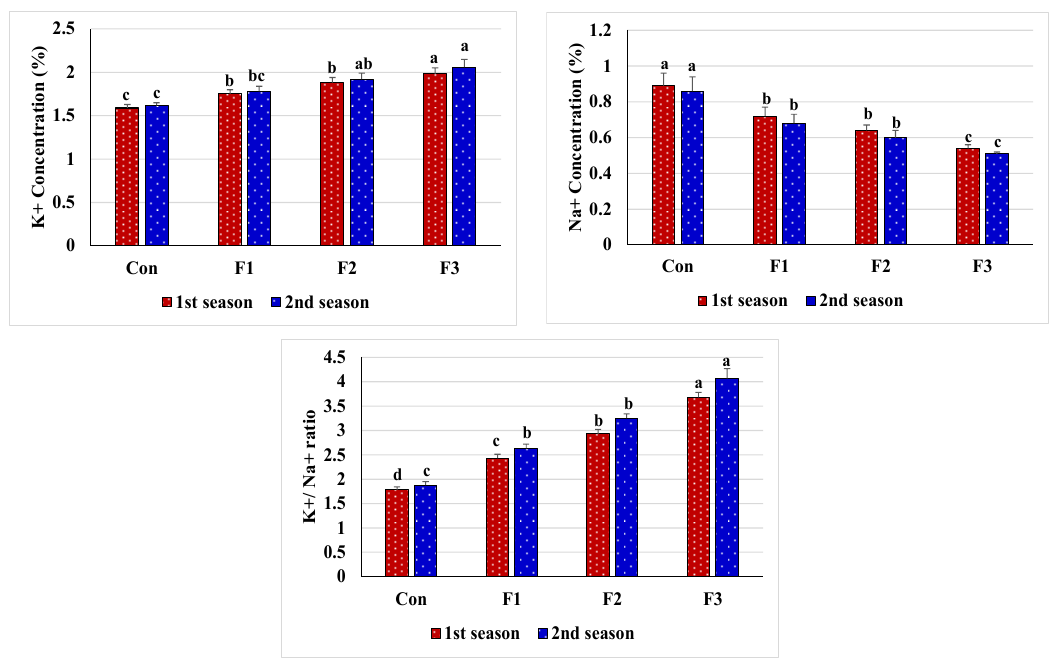
Figure 3. Nutrient content response of salt-stressed common bean plants (soil EC = 7.55–7.61 dS m − 1 ) to foliar nourishment with selenium dioxide nanoparticles (Se-NPs) in two consecutive seasons. Above bars, different letters are considered significantly different at p ≤ 0.05. Con, control (spraying leaves with distilled water); F1, spraying leaves with 0.5 mM Se-NPs; F2, spraying leaves with 1 mM Se-NPs; F3, spraying leaves with 1.5 mM Se-NPs; N, nitrogen; P, phosphorus; K + , potassium ion; Na + , sodium ion.